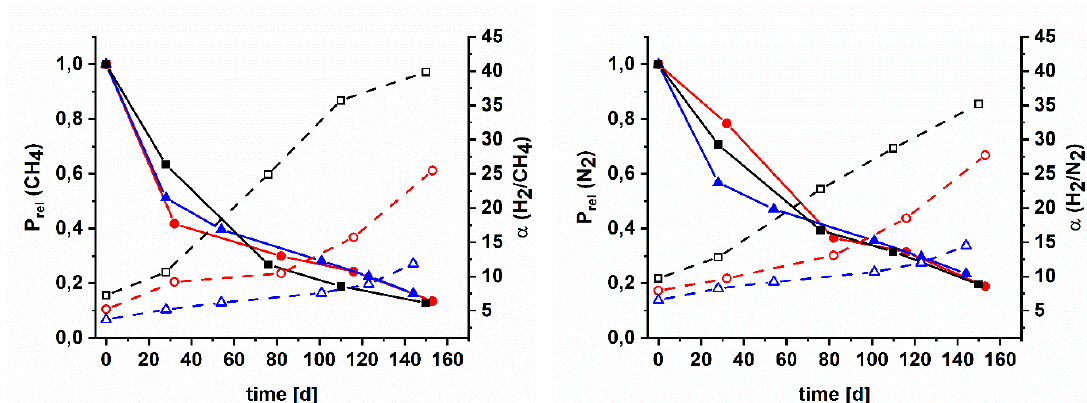
Figure 8. Relative permeability of CH 4 (left) and N 2 (right) (solid lines) versus time of AZ-PIM-100 (black squares), AZ-PIM-R50 (red circles) and AZ-PIM-A50 (blue triangles) and change of H 2 / CH 4 and H 2 /N 2 selectivity (dashed lines) during compaction.